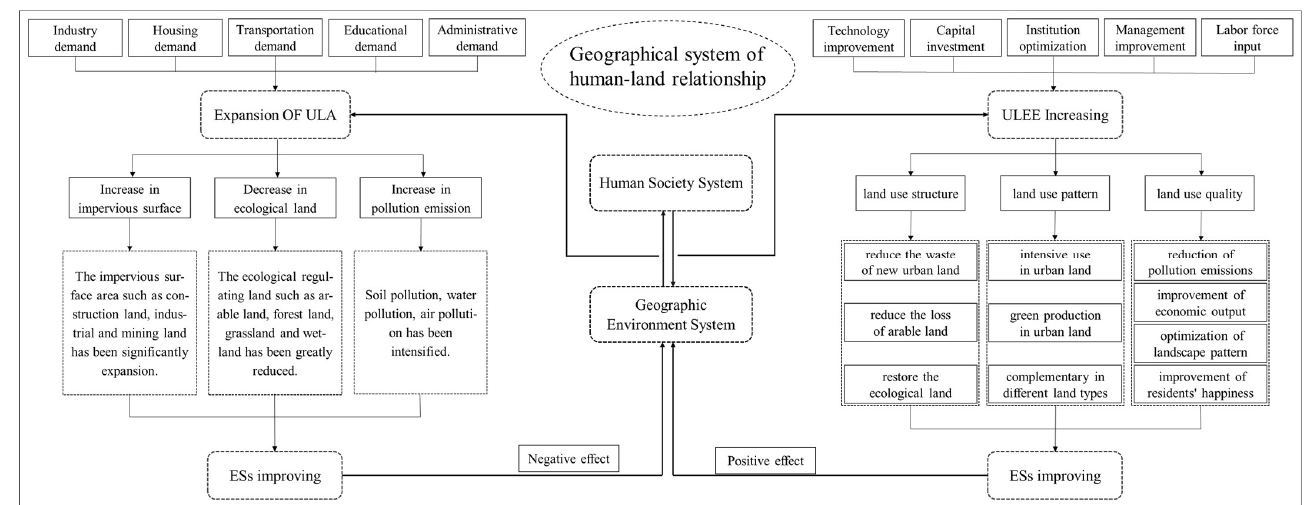
Figure 1. The mechanism framework of the impact of ULEE on ESs.